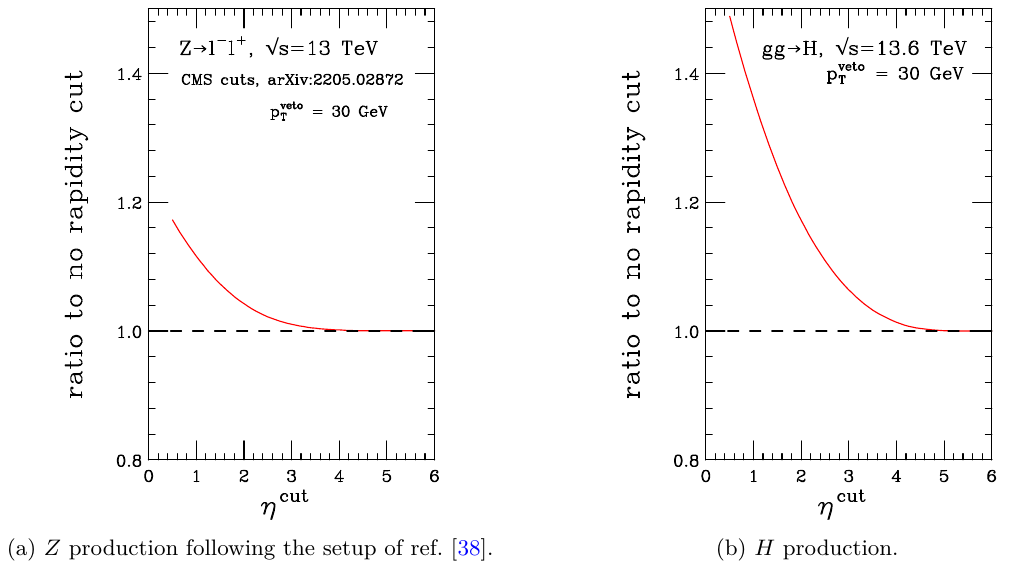
Figure 5 . Effect of the jet rapidity cut at NNLO with p veto